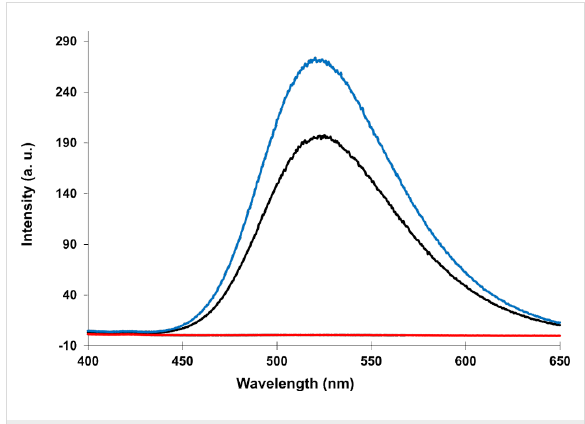
Figure 6: Fluorescence spectra of oligomer 1 (black), duplex 1*2 (blue) and duplex 1*6 (red) at 20 °C. Excitation: 370 nm. Conditions: see Table 1.